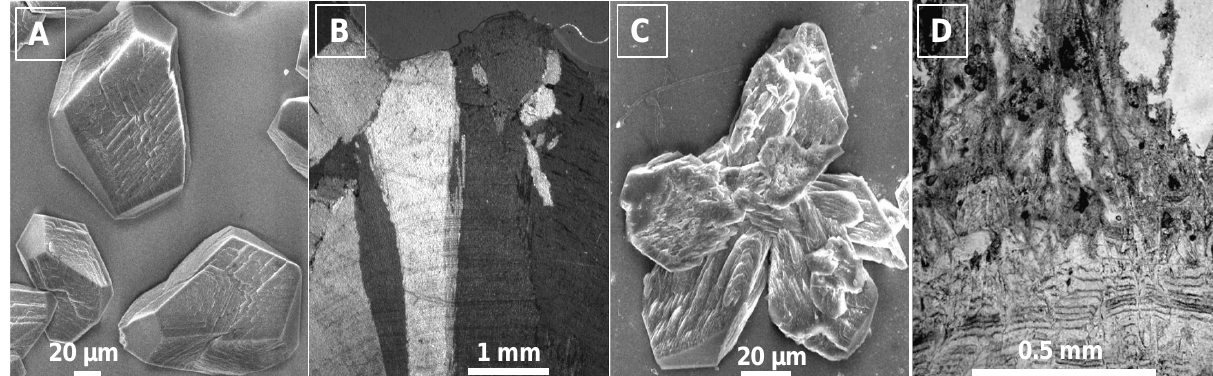
Fig. 4. Morphology of cave calcite precipitated on glass and corresponding stalagmite fabrics. (A) Calcite precipitate on glass slide collected in the DL cave between June and September 2003. The SEM image shows large crystals with flat, rhombohedra faces and stepped faces. (B) Optical microscope image (crossed polars) of the top of stalagmite SP1 from the SP cave that was active at the time of sampling (2003). Image shows columnar fabric of both compact and microcrystalline subtypes developing from crystals similar to those shown in (A) . (C) Cal- cite precipitate on glass slide collected over a one year period in the ER cave from December 2003. The SEM image shows many macrosteps and macrokinks on the irregular faces. (D) Optical microscope image of typical fabrics of stalagmite ER77. Bottom: annually laminated microcrystalline subtype of columnar fabric grading into highly porous dendritic fabric (top) arising from irregular crystals with lateral overgrowths as shown in (C)